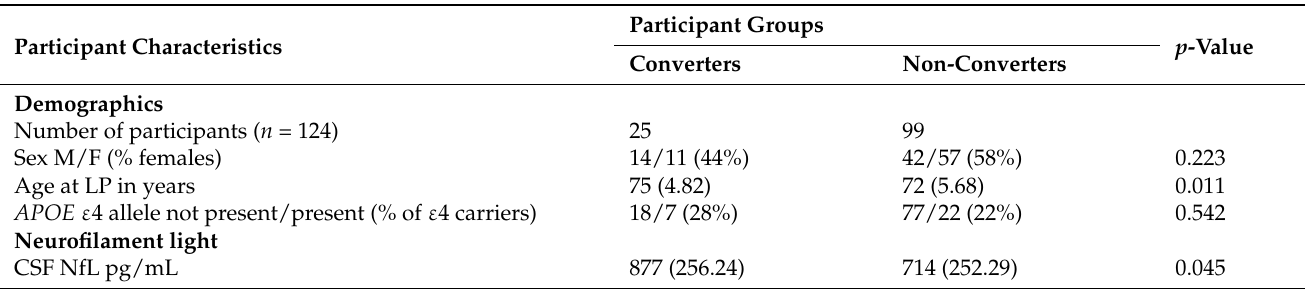
Table 2. Demographic characteristics and CSF NfL levels among cognitively healthy participants who converted to CDR ≥ 0.5 from CDR = 0 and non-converters.